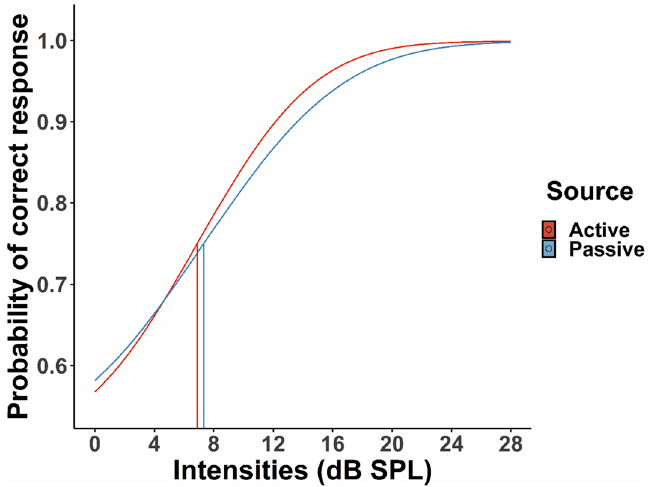
Figure 2. Group psychometric functions per source condition (active and passive) in the detection task. Vertical lines represent the mean thresholds per source condition (i.e., defined as the intensity accurately detected at 75% of the trials). Detection thresholds did not differ between active and passive trials ( p > .050).